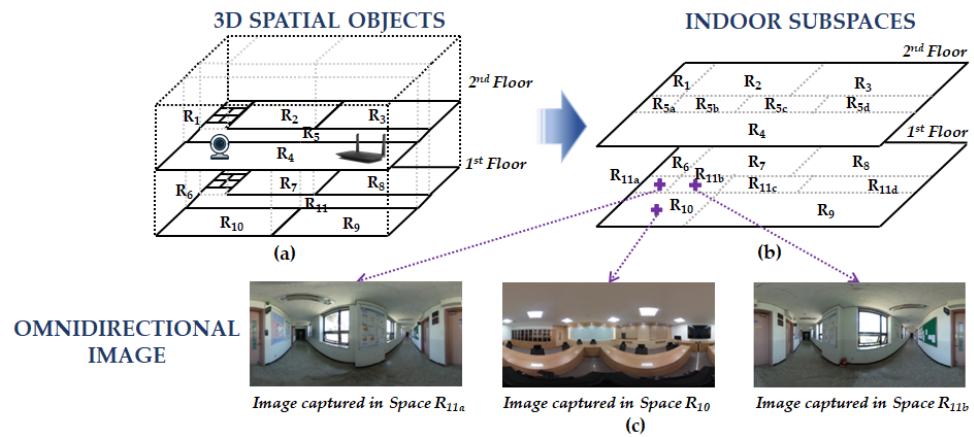
Figure 4. Collecting the omnidirectional images in the indoor subspaces: ( a ) 3D representation of a building; ( b ) subspaces composing the indoor space; ( c ) omnidirectional image captured at a shooting point for each subspace.